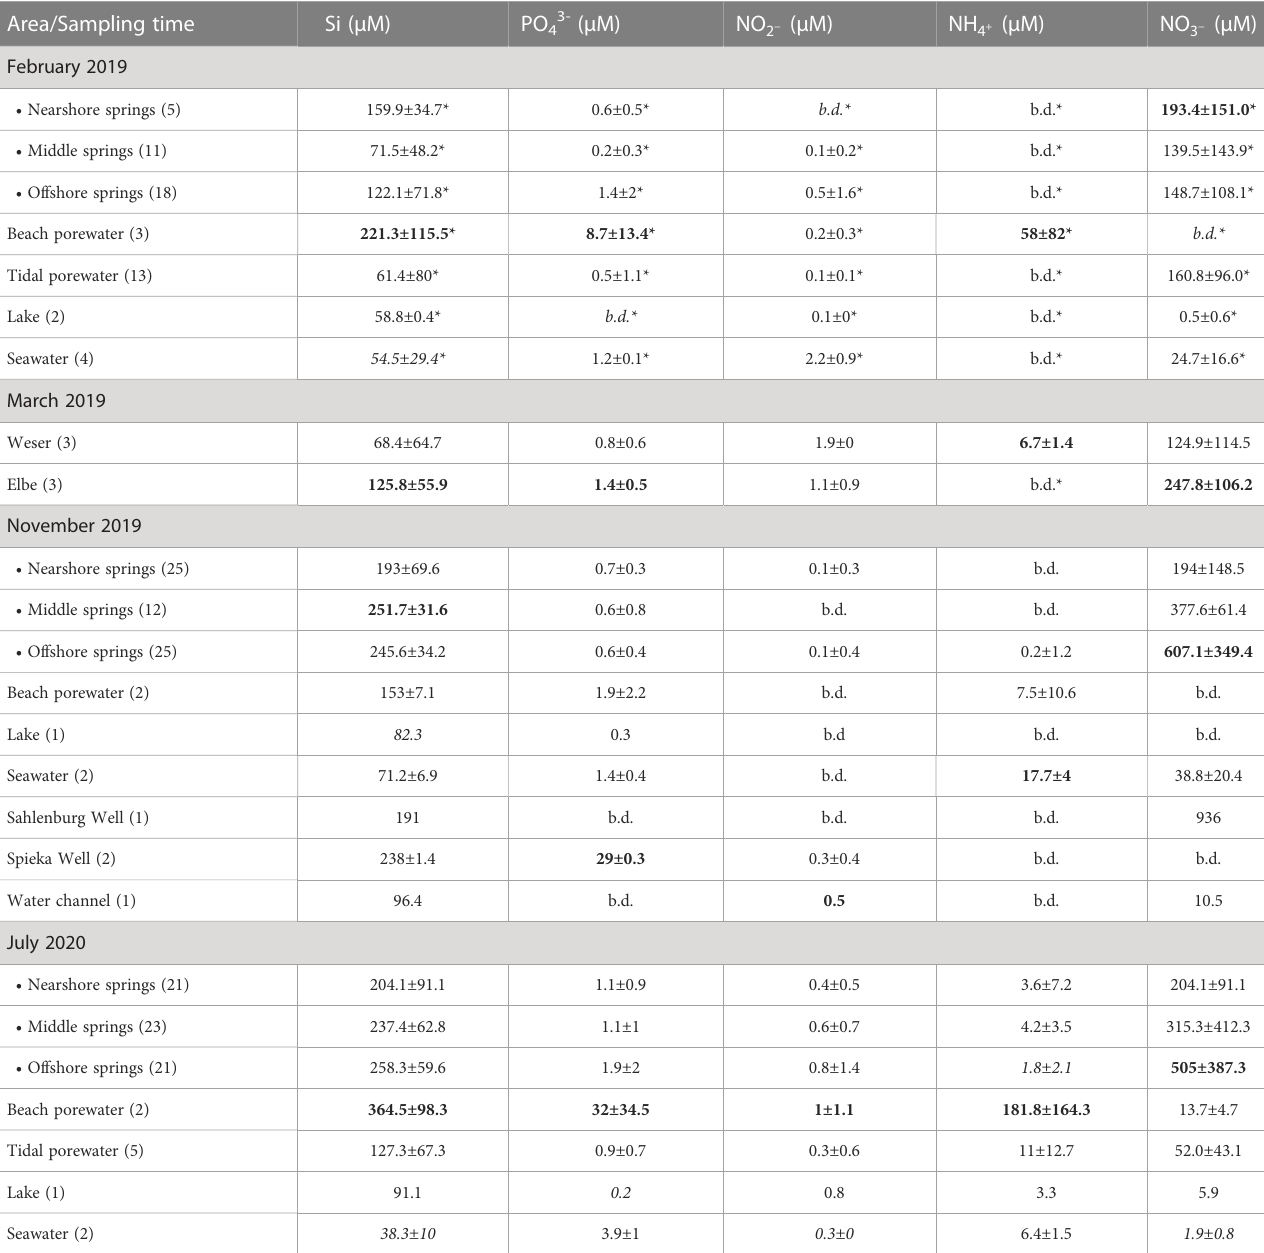
TABLE 1 Distribution of nutrients through the campaigns in the different locations. Area/Sampling